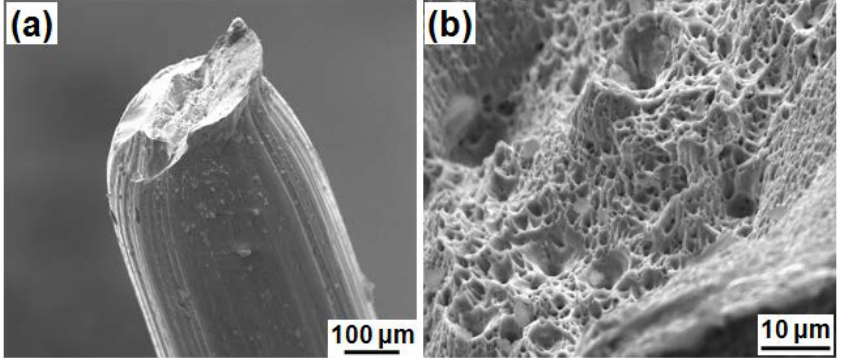
Figure 9: SEM fractographs of tensile tested unused wire rope: (a) low magnification (b) high magnification showing considerable reduction in size with dimple mode of